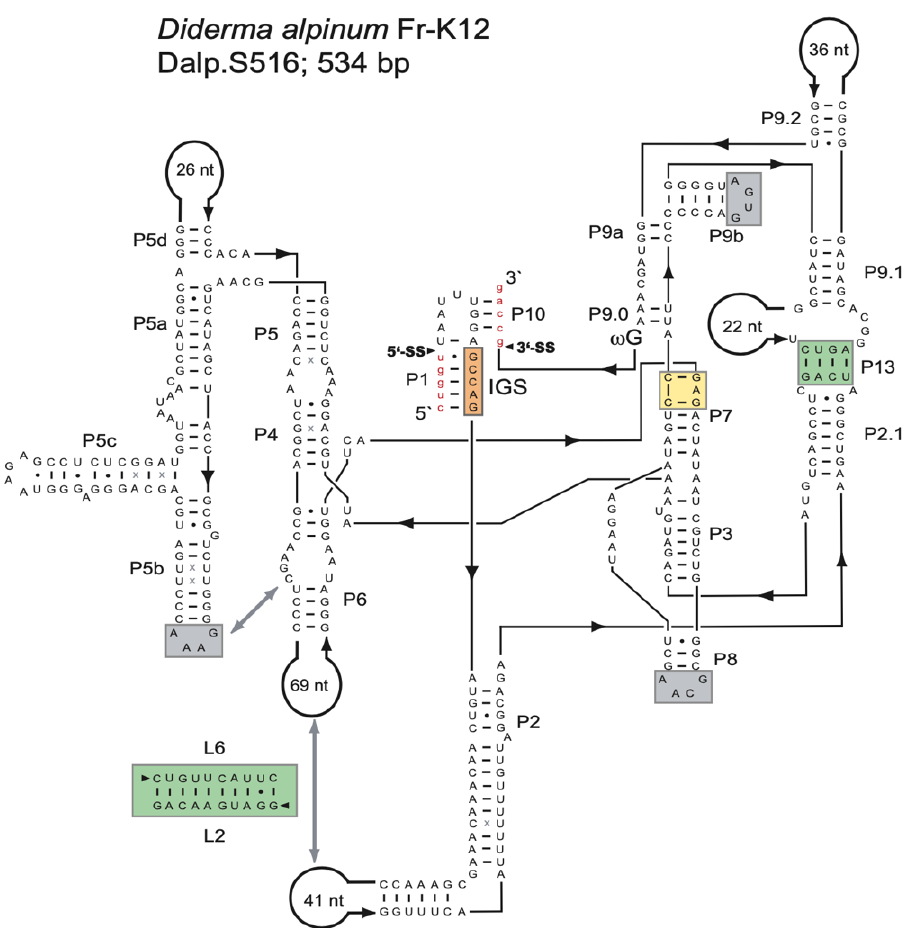
Figure 1. Secondary structure of the Diderma alpinum S516 group I intron RNA. The diagram of the representative 534-nt group IC1 intron RNA is presented according to [15]. The intron has a well-conserved core organization based on paired RNA segments (P1-P10). The guanosine binding site in P7 is indicated (yellow box), as well as the universal conserved terminal guanosine (ωG). Long-distance RNA–RNA interactions are commonly found in group I intron RNAs, involving receptors and GNRA-loops (gray boxes), or regular base pairings (green boxes). 5′ SS and 3′ SS, exon-intron pairing; (x) additional non-Watson–Crick base pairings with comparative support. Exon sequences are shown as red lowercase